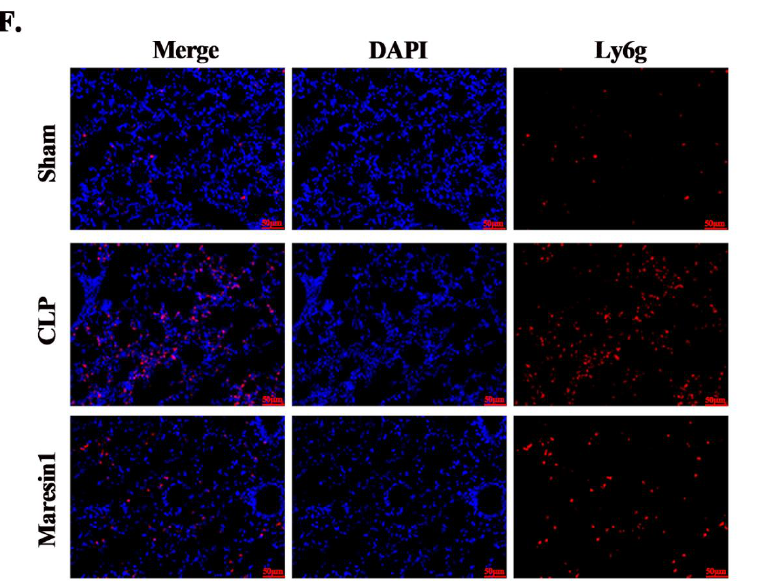
Figure 1. Maresin1 attenuates lung injury and neutrophil infiltration in septic lung injury. ( A ): The representative lung tissue HE staining results of different groups of mice (scale: 50 µ m, magnification 200 × ). ( B ): The number of neutrophils in the BALF was counted by using the Wright–Giemsa method. ( C ): The lung injury scores of all groups. ( D ): The relative proportions of neutrophils in different groups of BALF counted by the Wright–Giemsa method. the results of the neutrophil count in BALF. ( E ): The statistical results of neutrophil immunofluorescence staining corresponding to ( F ). ( F ): The immunofluorescence staining results of the neutrophils in the lung tissues e (scale: 50 µ m, magnification 200 × ). Data were presented as means ± SEM. ** p < 0.01 versus the Sham group; ## p < 0.01 versus the CLP